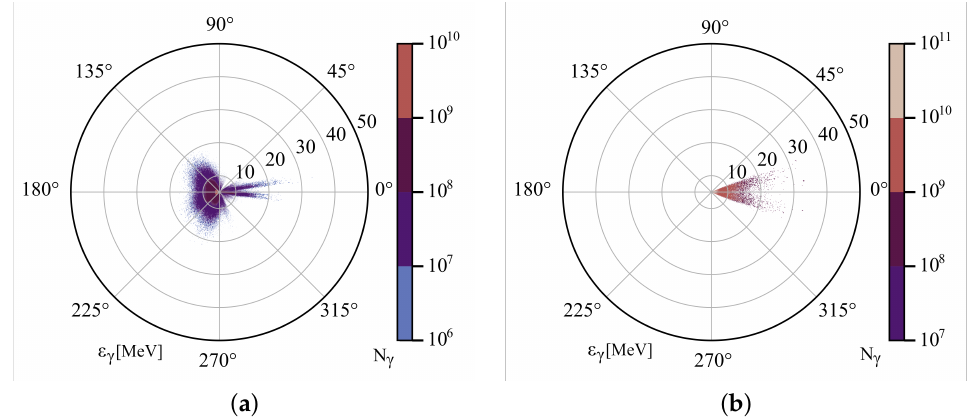
Figure 9. The energy angle distribution of the emitted γ -photons integrated in time, at 300 fs after the laser–plasma interaction begins, as obtained from a 2D PIC simulation. Laser parameters: λ = 1 µ m, a 0 = 85, τ = 20 fs FWHM and w 0 = 12.5 µ m. ( a ) Target parameters: n e 0 = 0.1 n c , L x = 120 µ m and